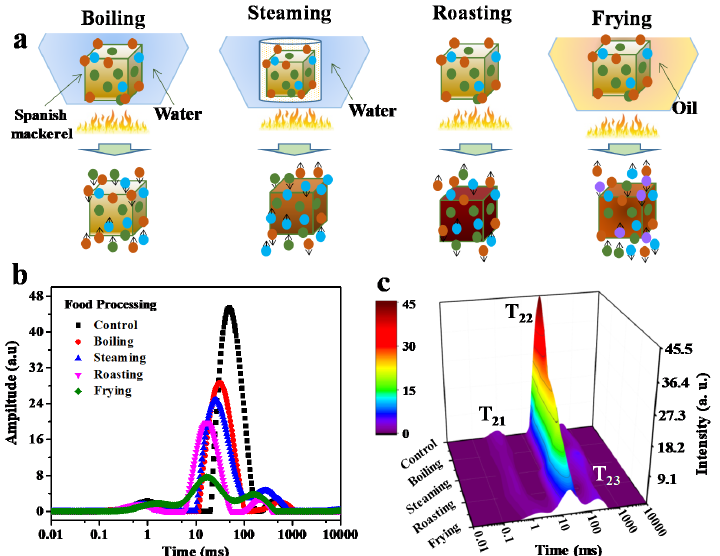
Figure 1. Schematic illustration of proton changes ( a ), T 2 relaxation time distribution curves ( b ) and T 2 relaxation spectra in 3D color map surface image ( c ) of Spanish mackerel before and after the treatment of boiling, steaming, roasting, frying ( T 21 , bound water, T 22 , immobilized water, T 23 , free water). Control sample is the fish meat before heating treatment.